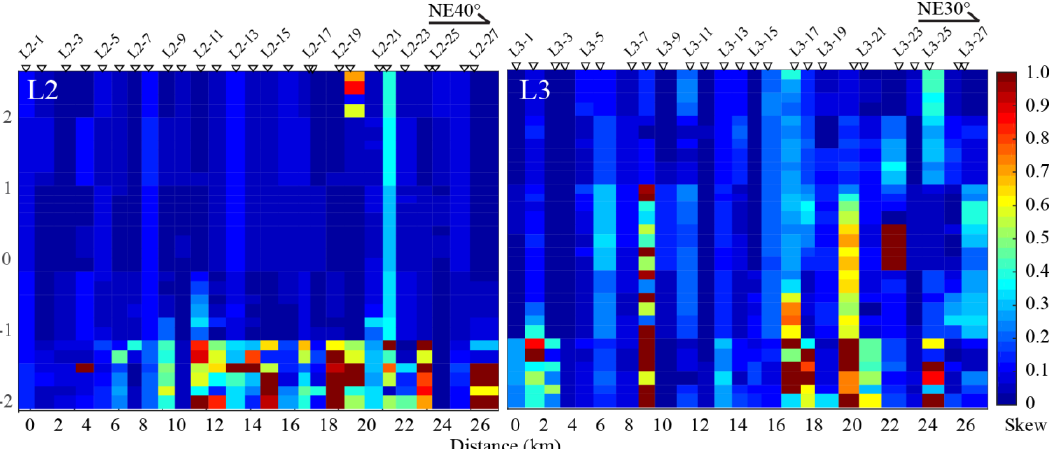
Figure 4. Dimensionality analysis results produced by the G-B impedance tensor decomposition algorithm [21] for the L2 and L3 profiles. Triangles with labels are MT stations.